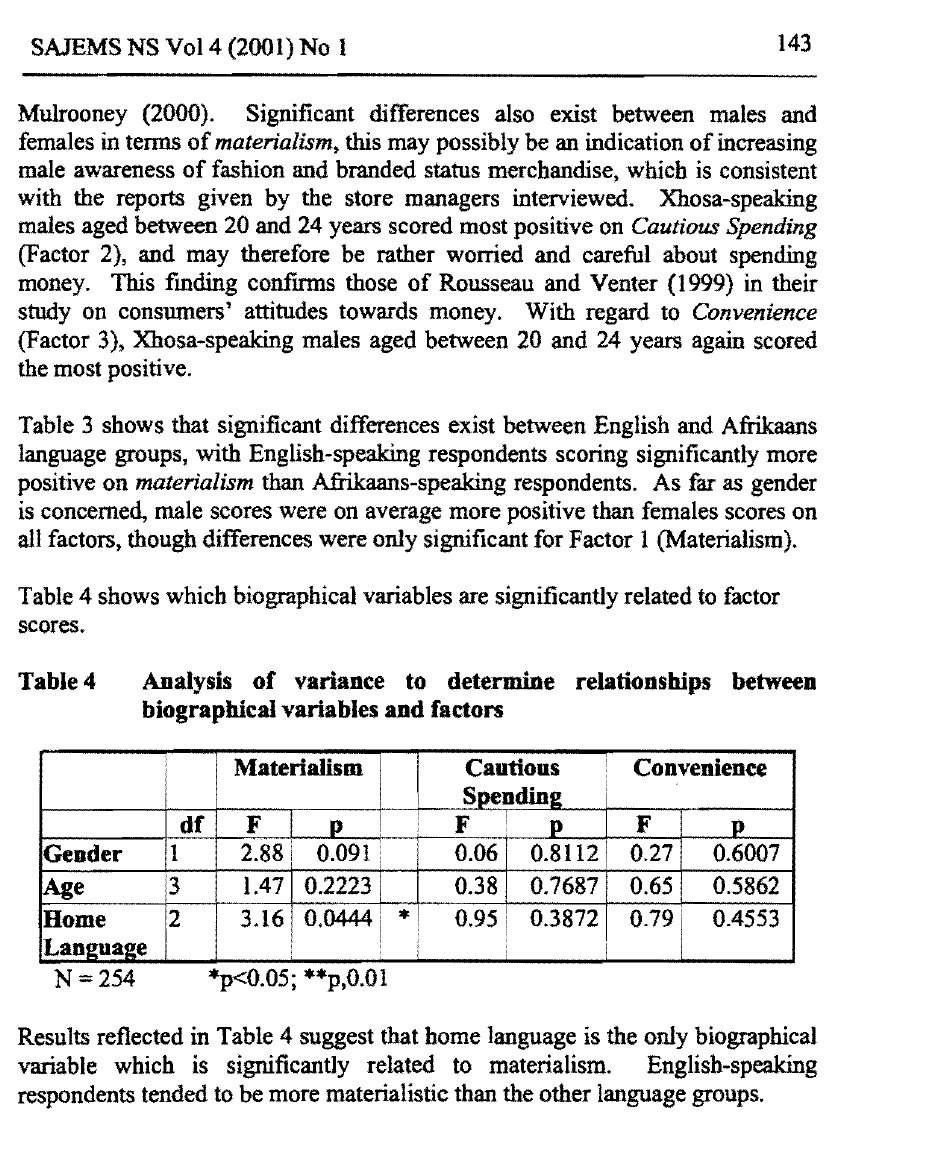
Analysis of variance to determine relationShips between biographical variables and